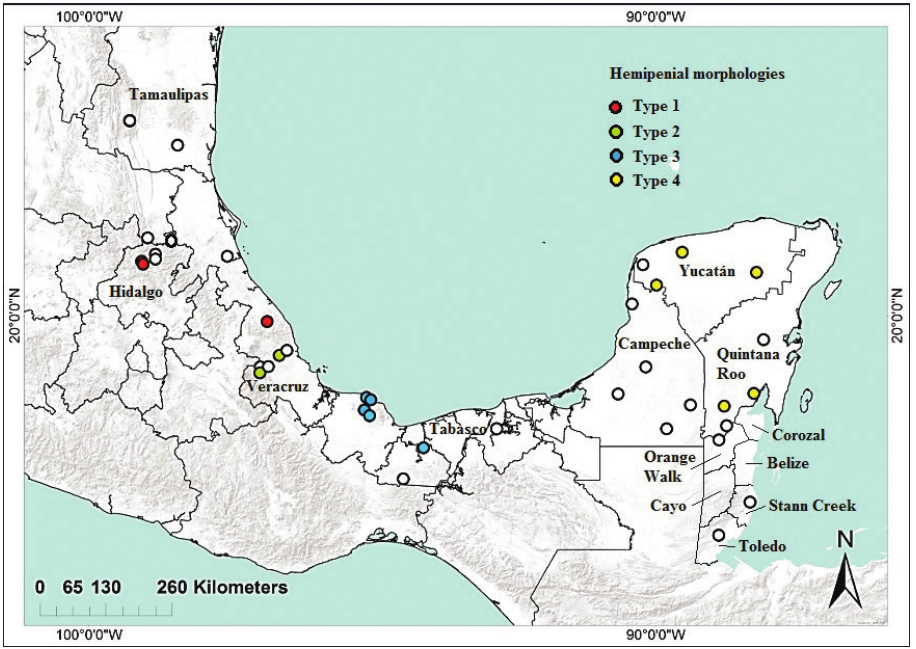
Figure 1. Localities of specimens examined in this study. Colored circles represent specimens with everted hemipenis (see text for details). Areas above 500 m shaded